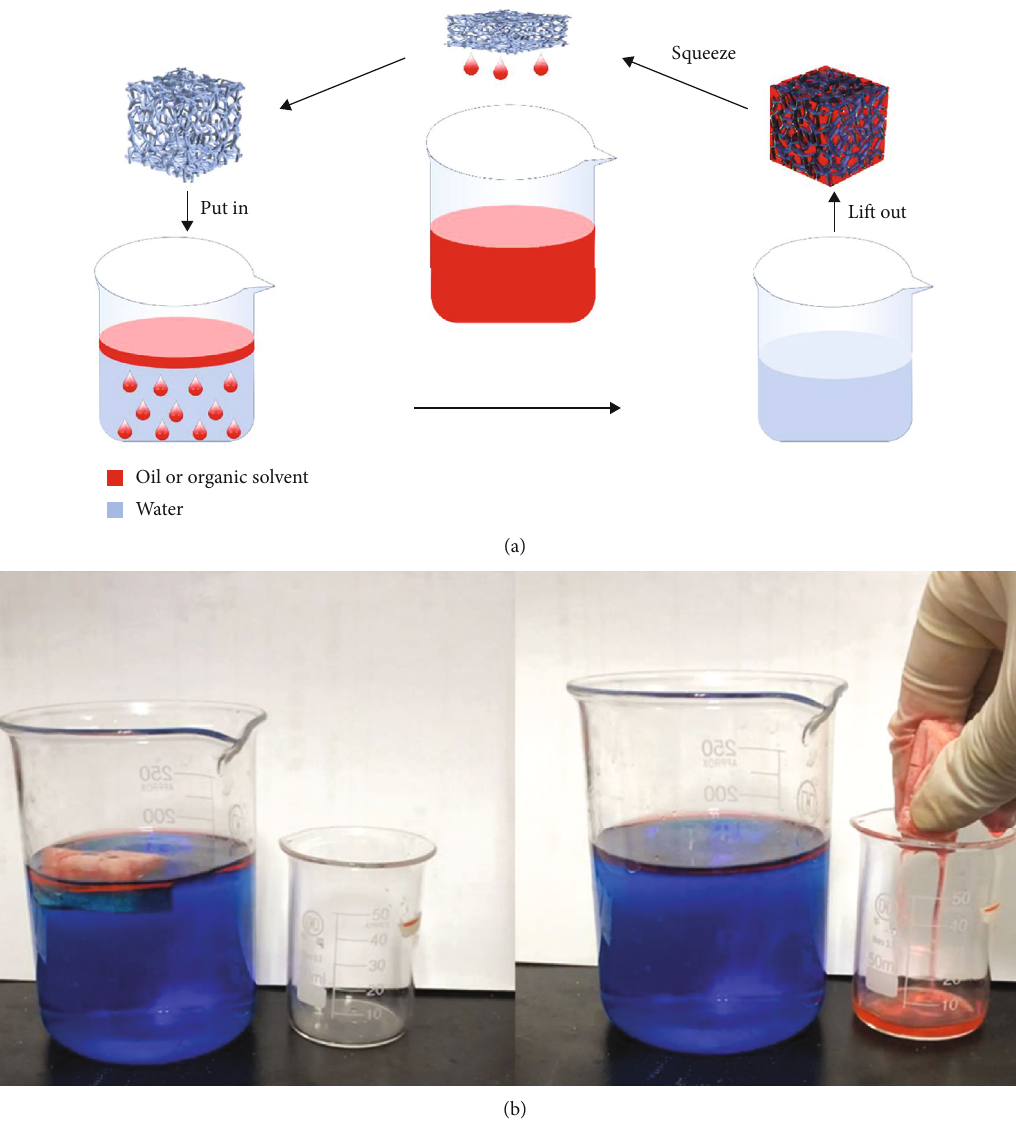
Figure 3: Modi fi ed sponges selectively absorbed and recovered oil from oil-water mixtures by immersion-extrusion.